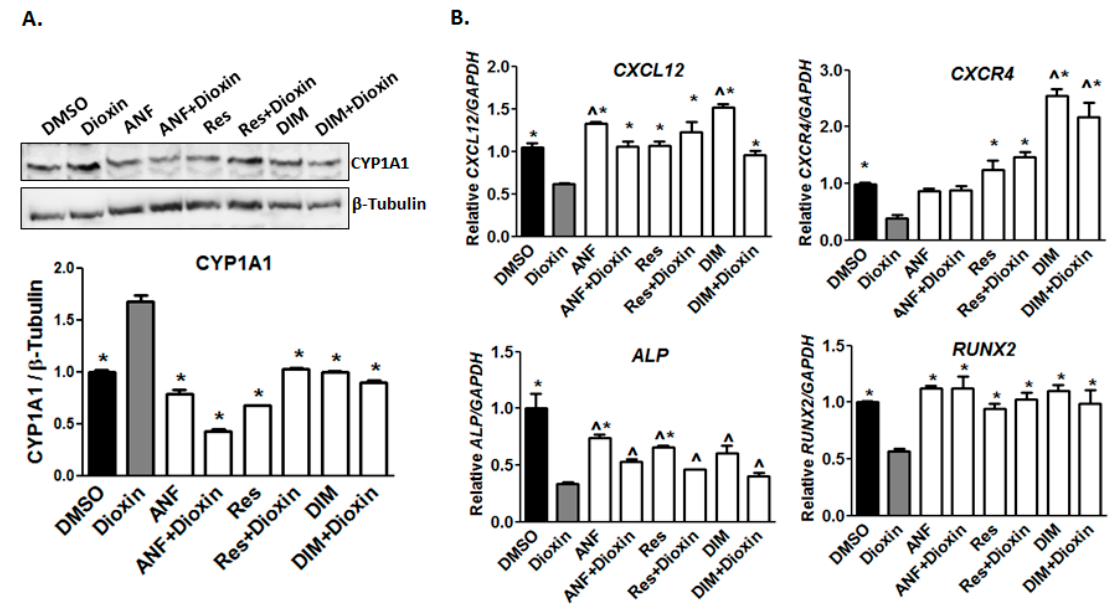
Figure 6. Osteogenesis-related gene expression after dioxin and AhR antagonist co-treatment. ( A ) CYP1A1 protein levels returned to near-baseline levels with AhR antagonist co-treatment. * p < 0.05 relative to 100 nM dioxin condition; ( B ) CXCL12 mRNA expression was recovered by co-treatment with AhR antagonists. CXCR4 mRNA expression was restored to control levels or higher by co-treatment with resveratrol and 3,3 ′ -diindolylmethane (DIM). ALP and RUNX2 mRNA expression was recovered by AhR antagonist co-treatment. * p < 0.05 relative to 100 nM dioxin condition, ^ p < 0.05 relative to 0 nM dioxin condition. Error bar means ± SEM.